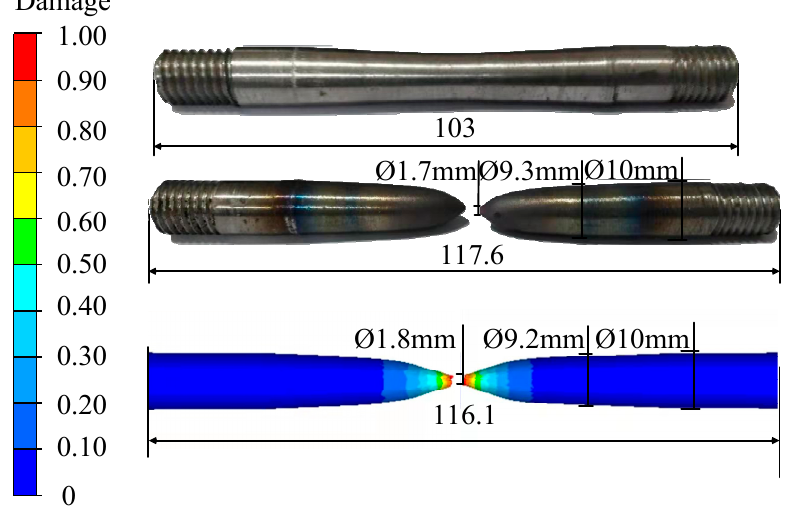
Figure 11. Schematic diagram of the comparison of gauge distance and tensile fracture between simulated tensile specimen and actual tensile specimen at 950 °C and 5 s − 1 (unit: mm).